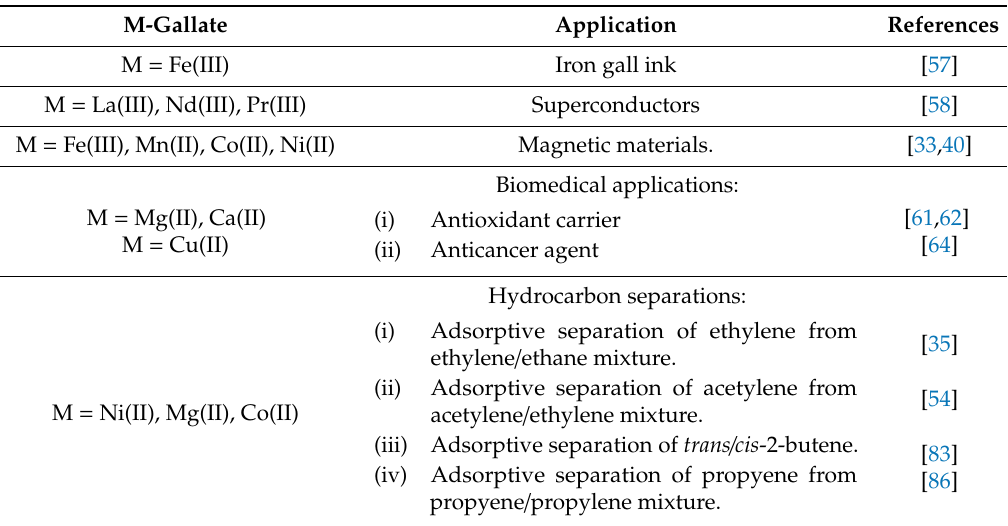
Table 1. Previous studies on gallate-based